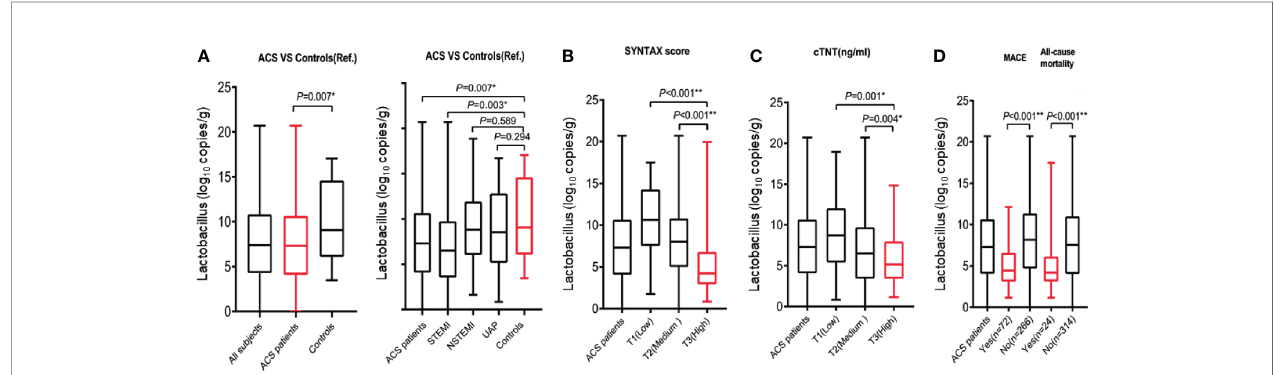
FIGURE 1 | Relationship between Lactobacillus and measures of coronary artery lesion and clinical myonecrosis. (A) Left panel, Lactobacillus levels signi fi cantly increased in the ACS patients compared with that in the control group. Right panel, Lactobacillus levels signi fi cantly increased in the STEMI subgroup compared with that in the control group. In the 402 ACS patients with an evidence of coronary artery lesion, Lactobacillus levels were signi fi cantly higher with (B) increasing SYNTAX score, (C) clinical myonecrosis [quanti fi ed by cardiac troponin T (cTnT)] tertiles, and (D) proportion of all-cause death and MACE. *p < 0.05; **p <